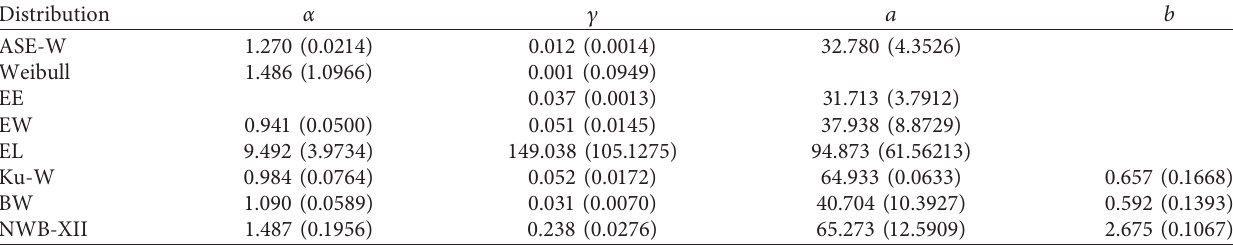
Table 7: Estimated parameters along with standard errors (in parenthesis) of the fitted models.